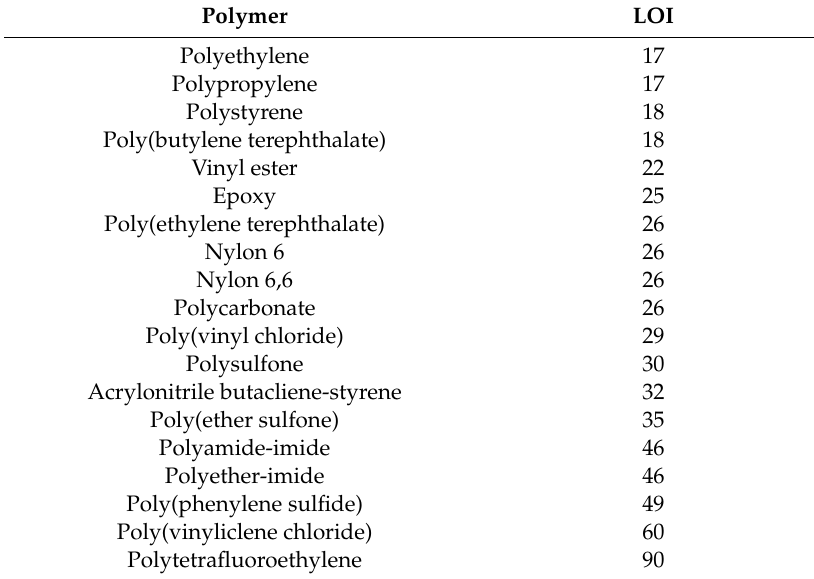
Table 7. Limiting-oxygen index (LOI) values (vol%) of common commercial polymers [40]. Polymer LOI